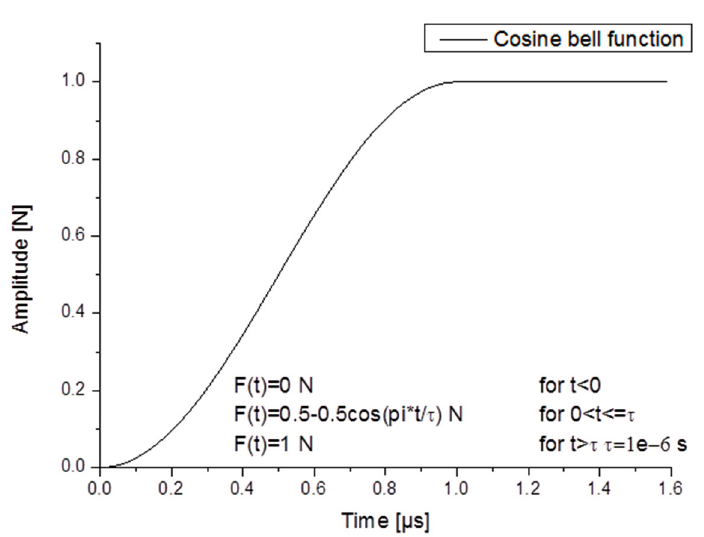
Figure 2. PLB‚ Cosine bell’ source characteristics.